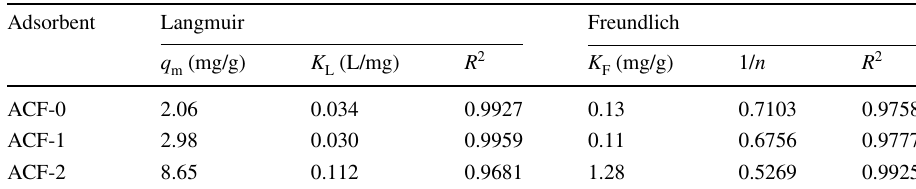
Table 2 Values of adsorption parameters obtained from the Langmuir and Freundlich models with the different ACFs (ACF-0, ACF-1 and ACF-2)